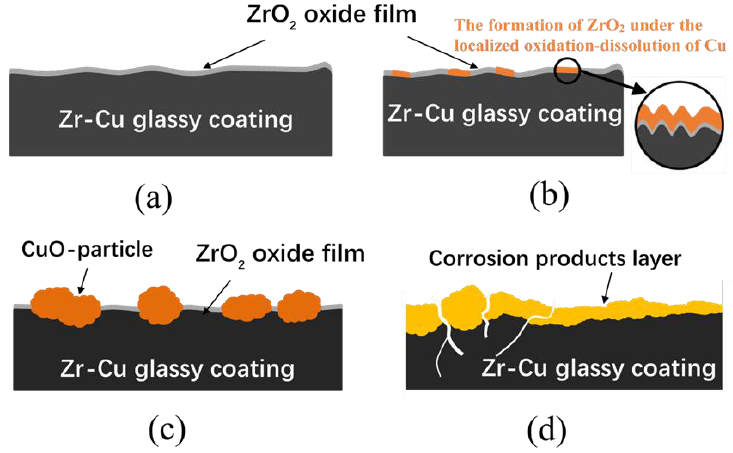
Figure 11. Surface morphologies models of Zr-Cu glassy coating corrosion for 16 h in 0.01 M deaerated H 2 SO 4 solution at ambient temperature; ( a ) Zr-30 at.% Cu; ( b ) Zr-50 at.% Cu; ( c ) Zr-80 at.% Cu; ( d ) Zr-90 at.% Cu.